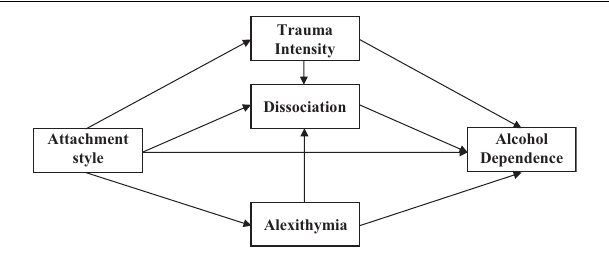
FIGURE 1 | A graphical model presenting the nature of dependencies between attachment styles and trauma, dissociation, and alexithymia, in explaining an inclination to alcohol addiction risk. Source: Zdankiewicz- ´Scigała